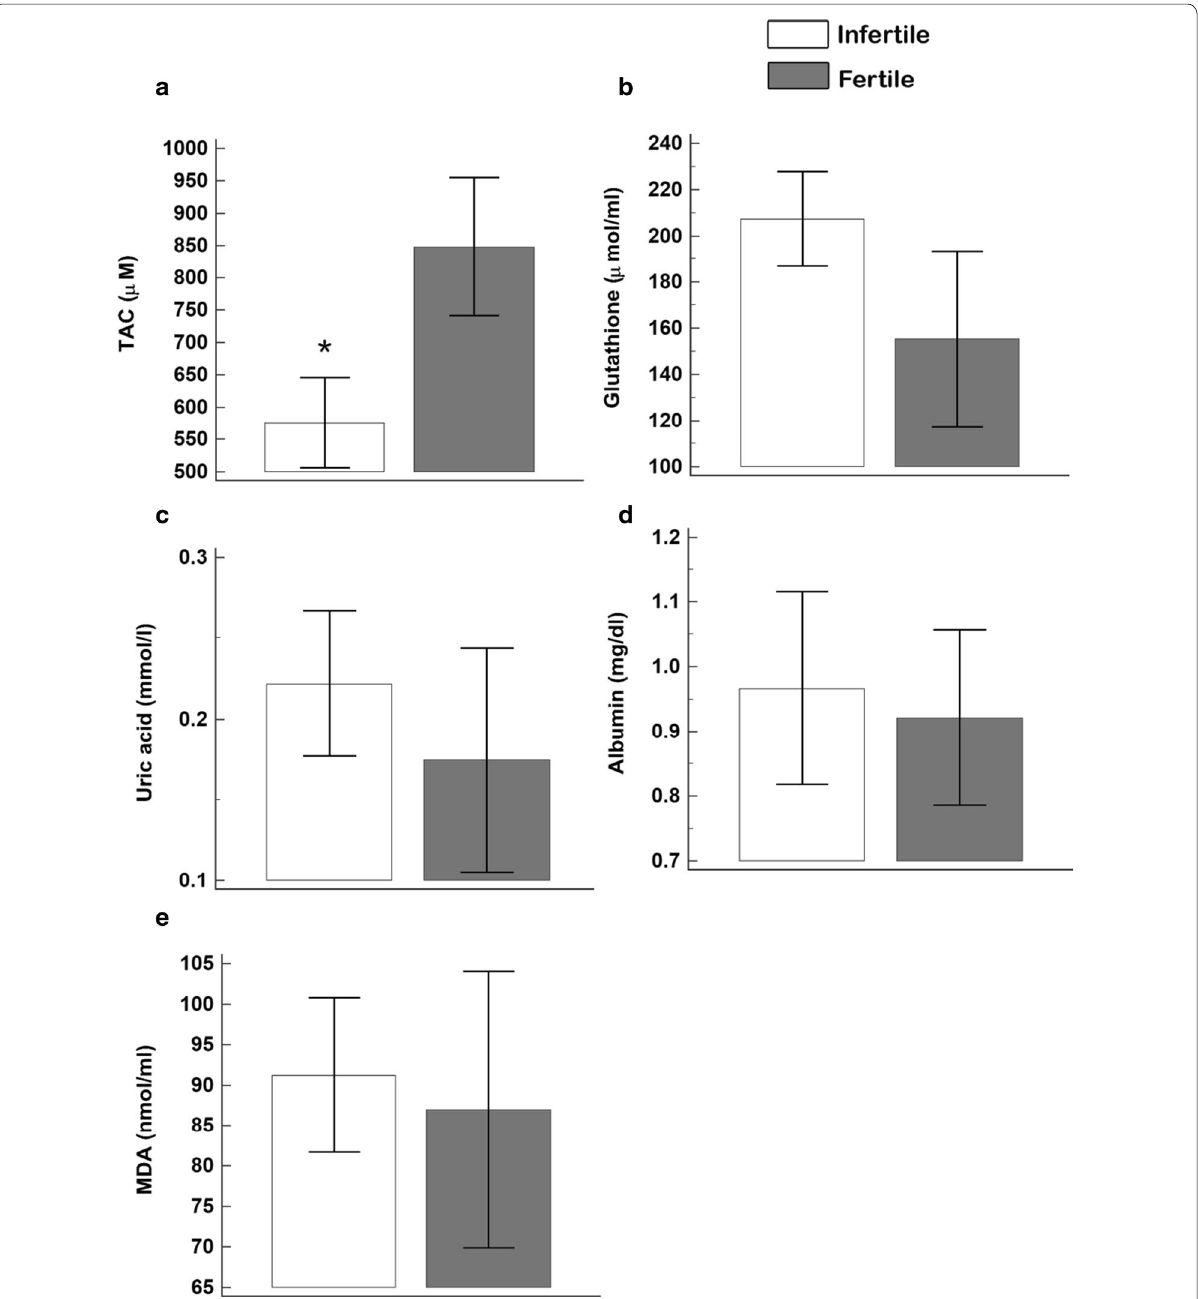
Fig. 1 Semen oxidative stress markers of normozoospermic infertile and fertile men in seminal plasma a TAC, b glutathione, c uric acid, d total protein and e MDA. *Significant ( p < 0.001) versus